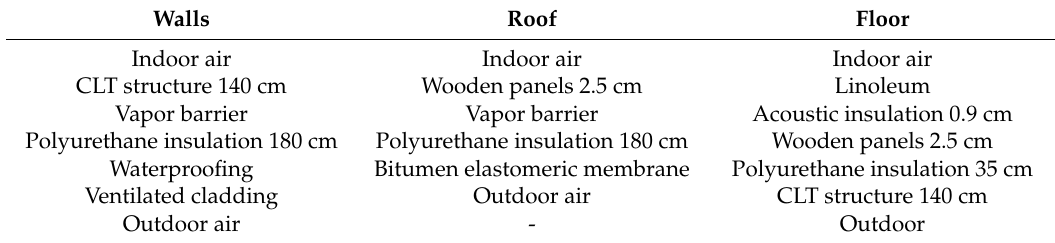
Table 1. Construction technology of TI1, used as reference